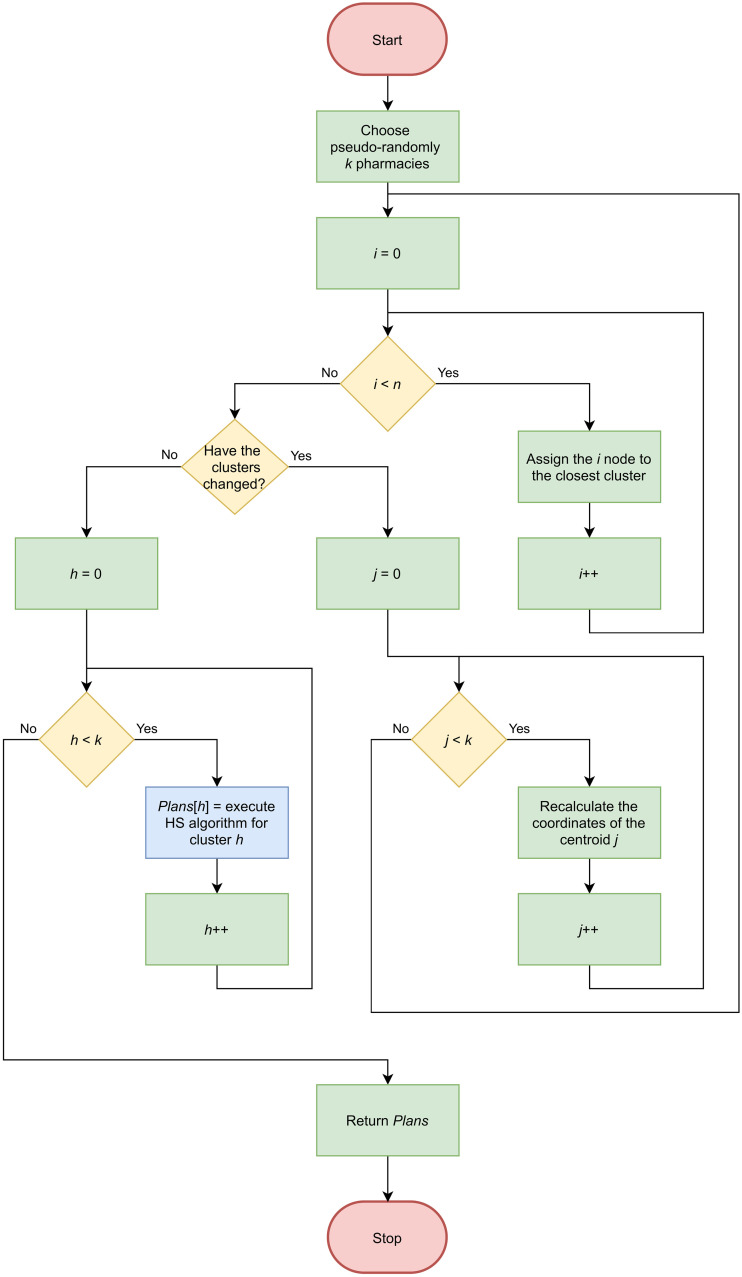
Flowchart of the proposed approach.